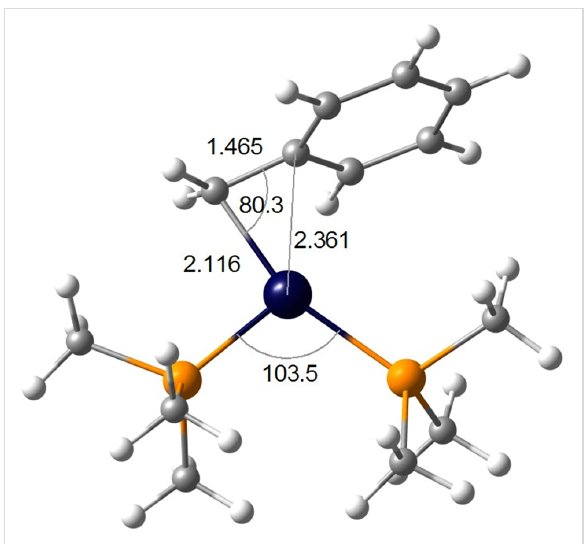
Figure 21: DFT-optimized structure of intermediate 86 [62]. Bond distances in angstrom and angles in degrees.